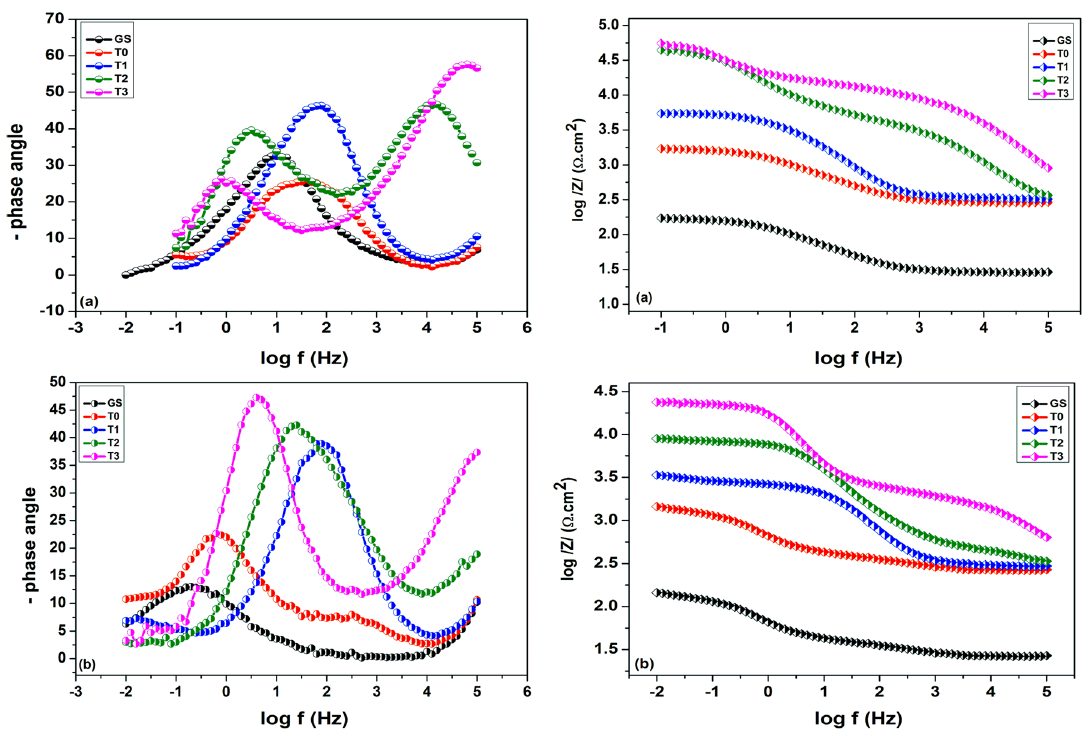
Figure 9. Bode diagrams obtained for the coated samples and for uncoated galvanized steel 0.05 mol.L –1 NaCl: (a) 24 hours and (b) 96 hours.